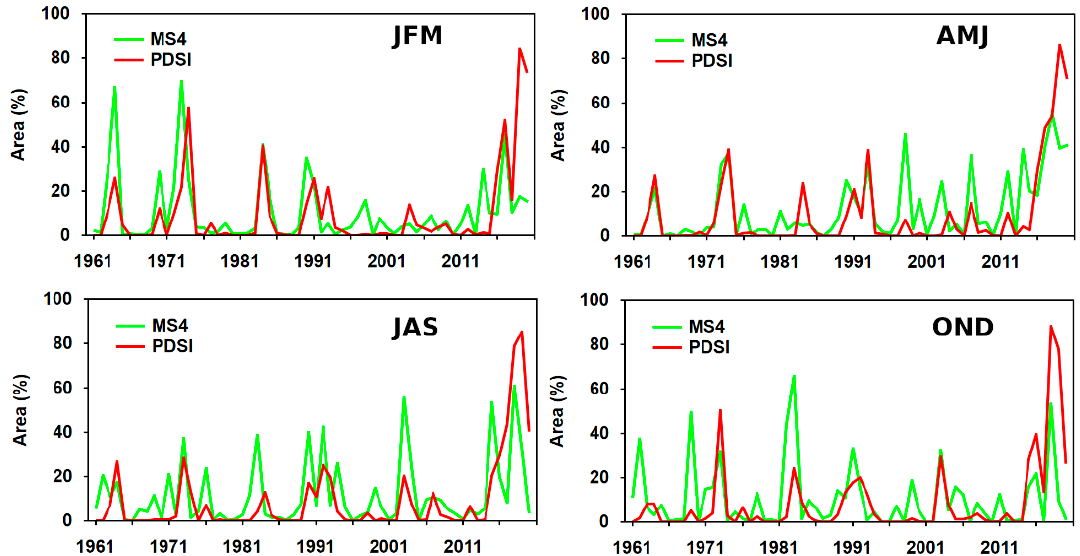
Figure 7. Fluctuations in the area of 10th-percentile soil drought (% of grid points) according to MS4 and PDSI for JFM, AMJ, JAS, and OND in the Czech Republic during the 1961–2020 period. Table 3. Linear trends in the area exhibiting 10th-percentile soil drought (% of grid points per 10 years) in the 0–100-cm soil layer according to MS4 and PDSI for JFM, AMJ, JAS, OND, SHY, and WHY in the Czech Republic during the 1961–2020 period. Statistically significant linear trends, at a 0.05 significance level, appear in bold